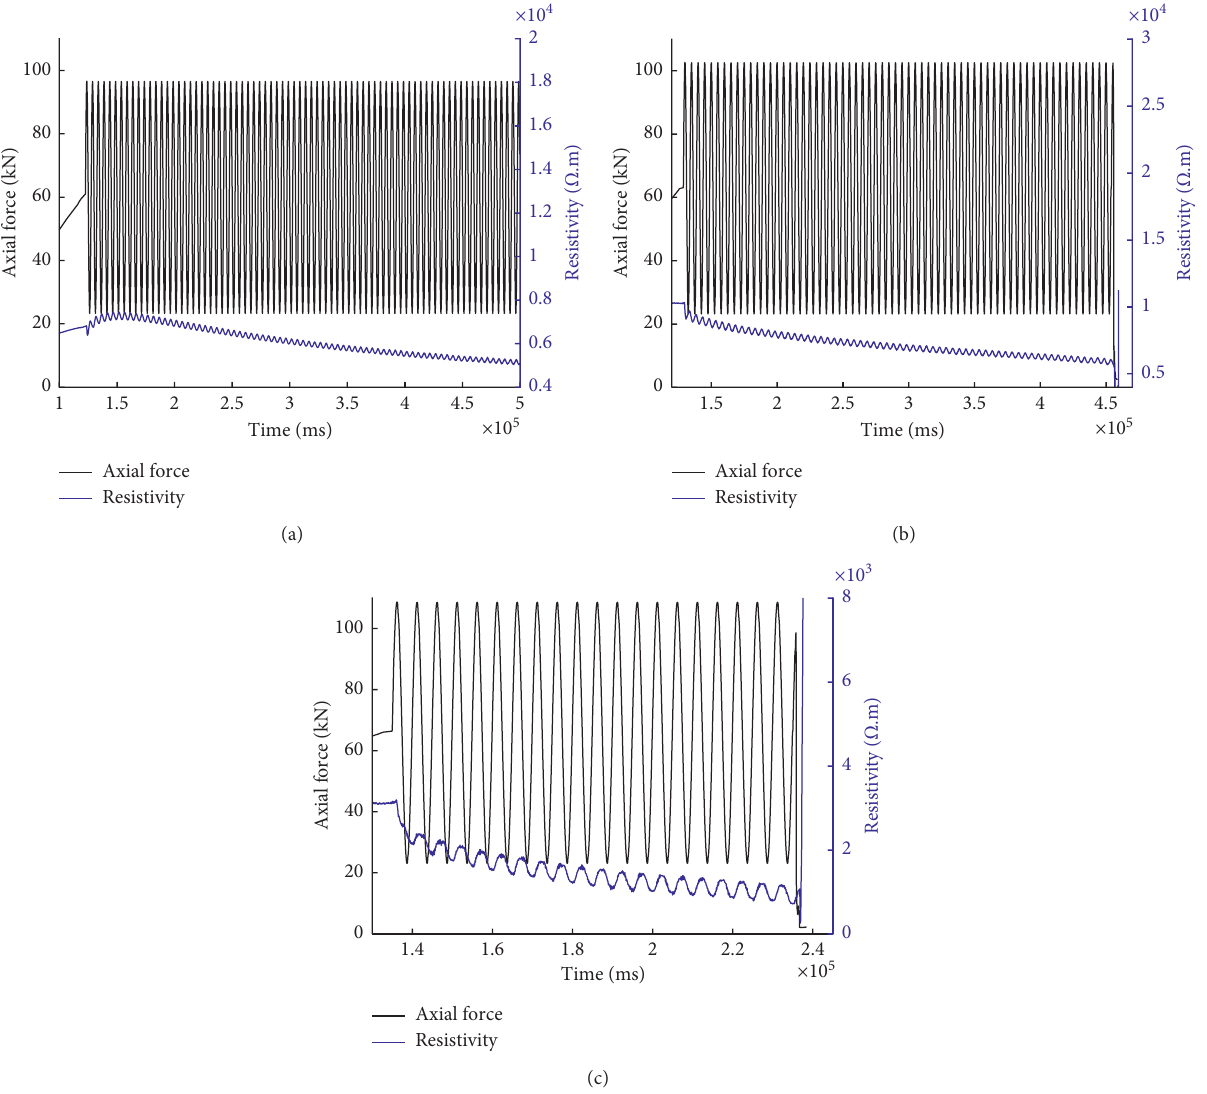
Figure 7: The resistivity evolution law of sandstone under different stress amplitude conditions. (a) Evolution of resistivity at 20%–80% stress level. (b) Evolution of resistivity at 20%–85% stress level. (c) Evolution of resistivity at 20%–90% stress